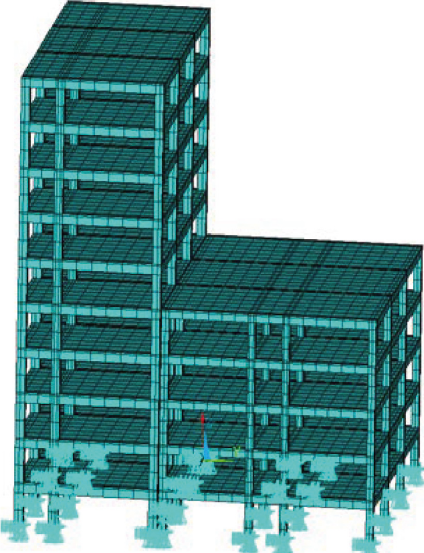
Figure 10: Analyzed ANSYS model of two adjacent frame structures.